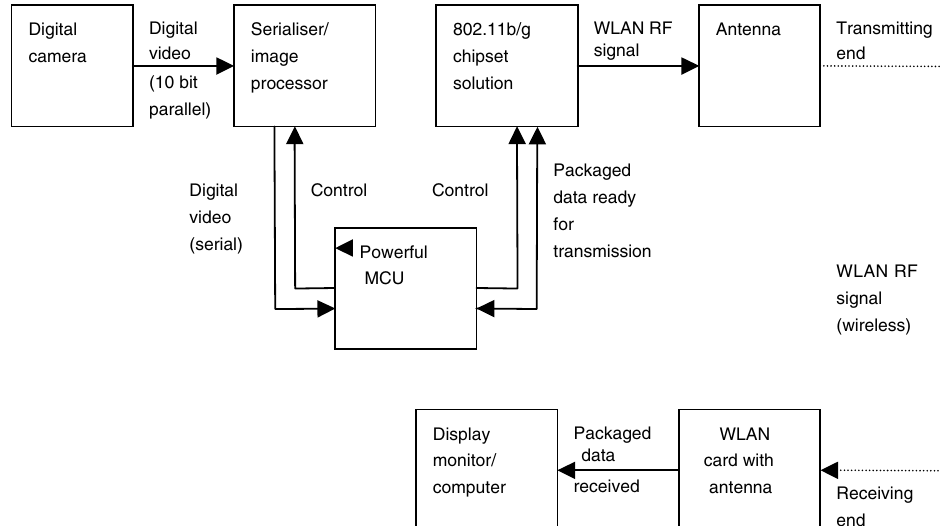
Figure 7 Block diagram of solution 3: digital camera + digital video transmission using WLAN technology.